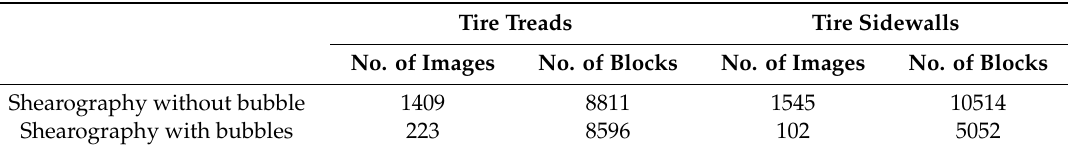
Table 2. Training Dataset Details.